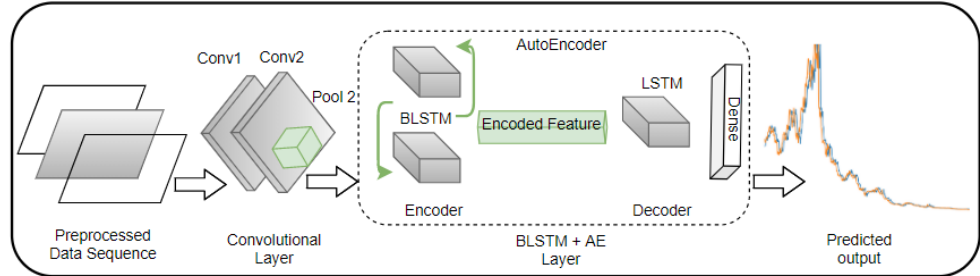
Figure 1. Proposed CBLSTM-AE energy prediction